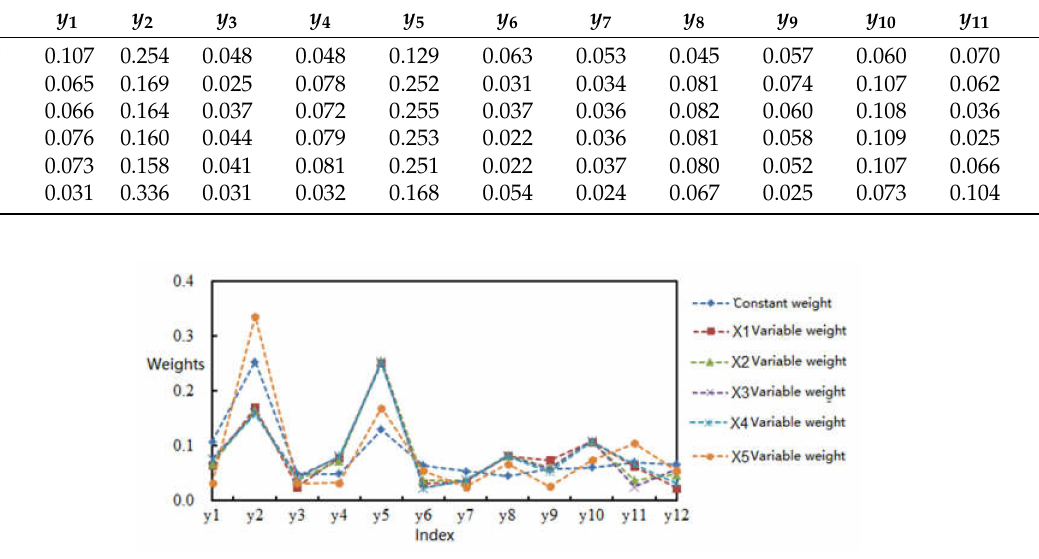
Figure 4. Comparison between the constant weights and variable weights of the evaluation index for each slope rock mass (the quantity of X is associated with the slope rock